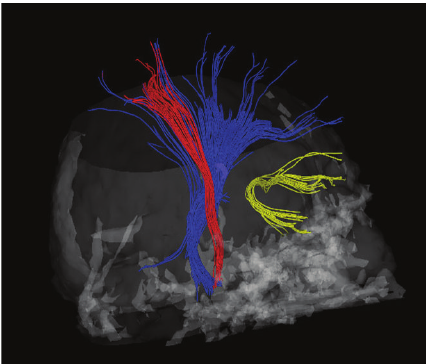
Figure 6: Spatial relation of the superior longitudinal fasciculus and the U -shaped fibers (green) to the corpus callosum (red).